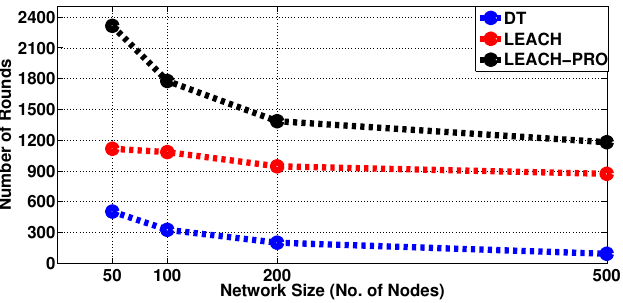
Figure 12. HND evolution under varying WSN densities.